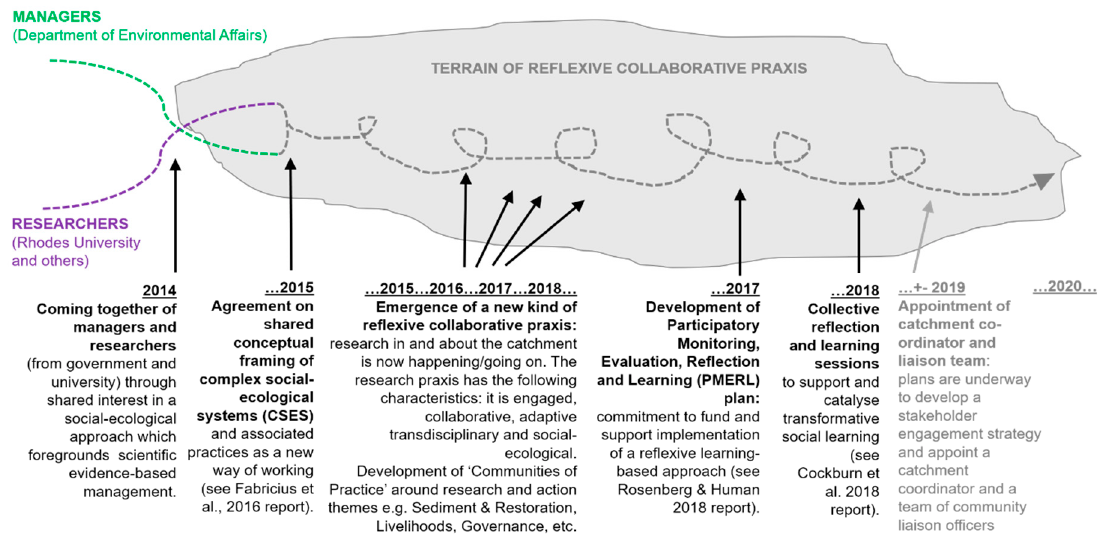
Figure 3. Key moments in the learning story of the Tsitsa Project [22,32].